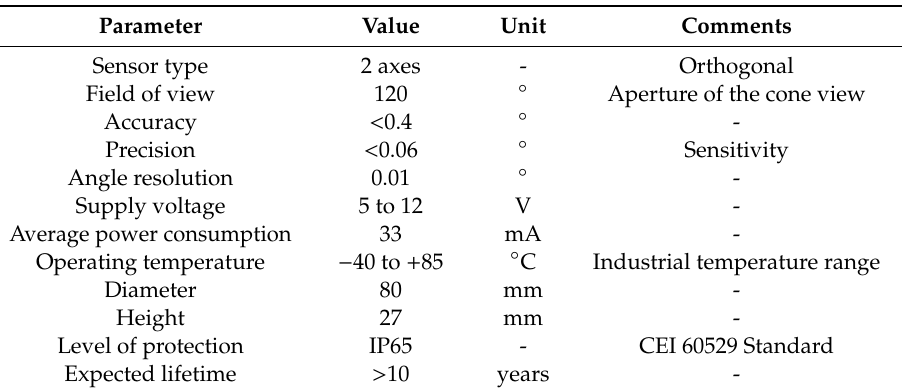
Table 1. ISS-D60 features.